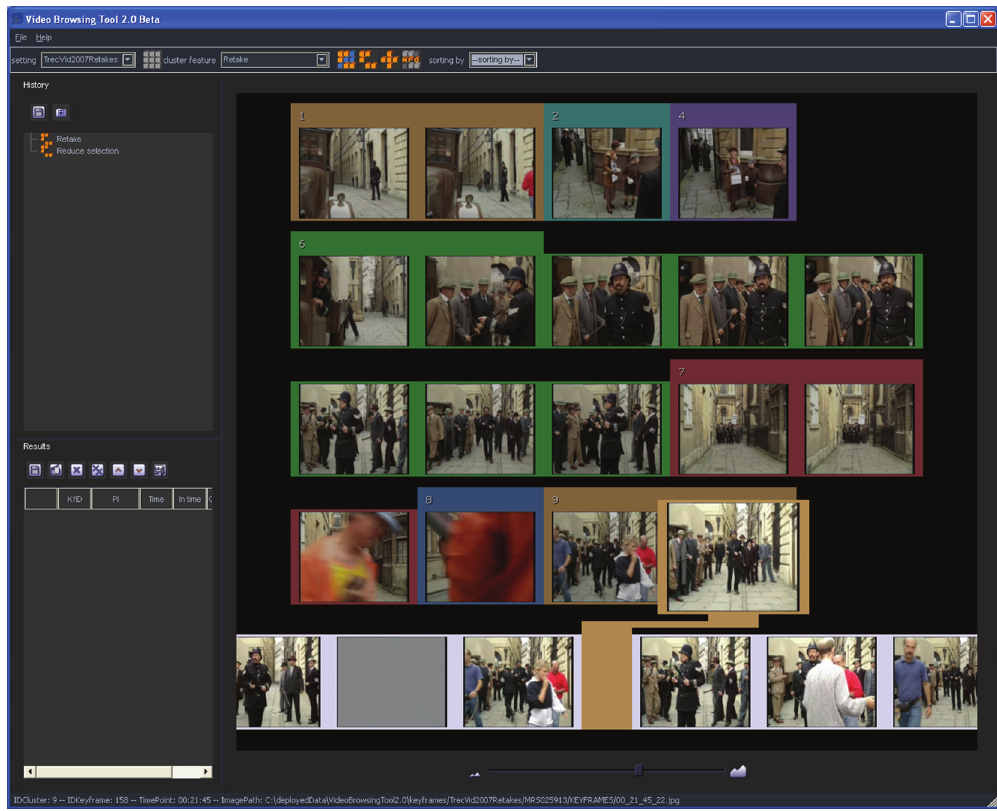
Figure 6: Screenshot of the video browsing tool: repeated takes. The images in the bottom row show the temporal context of the key frame under the mouse cursor.